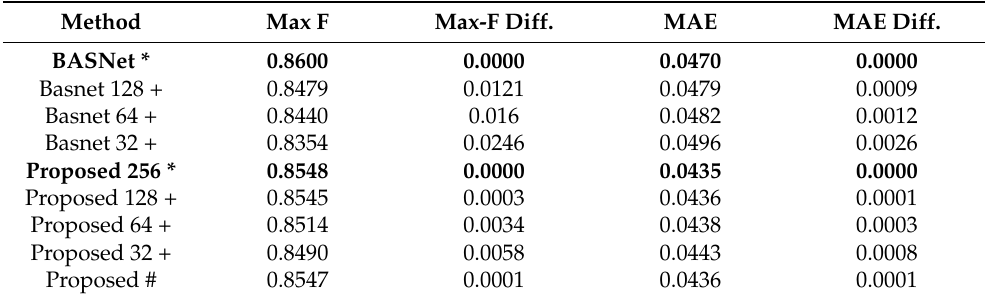
Table 1. Comparison of Max-F and MAE results on different scenarios where (*) is BR, (+) is SKR, and (#) is SQR in DUTS-TE. Each result is compared with BR as the baseline (bold style font) to see the difference between Max-F and MAE value.